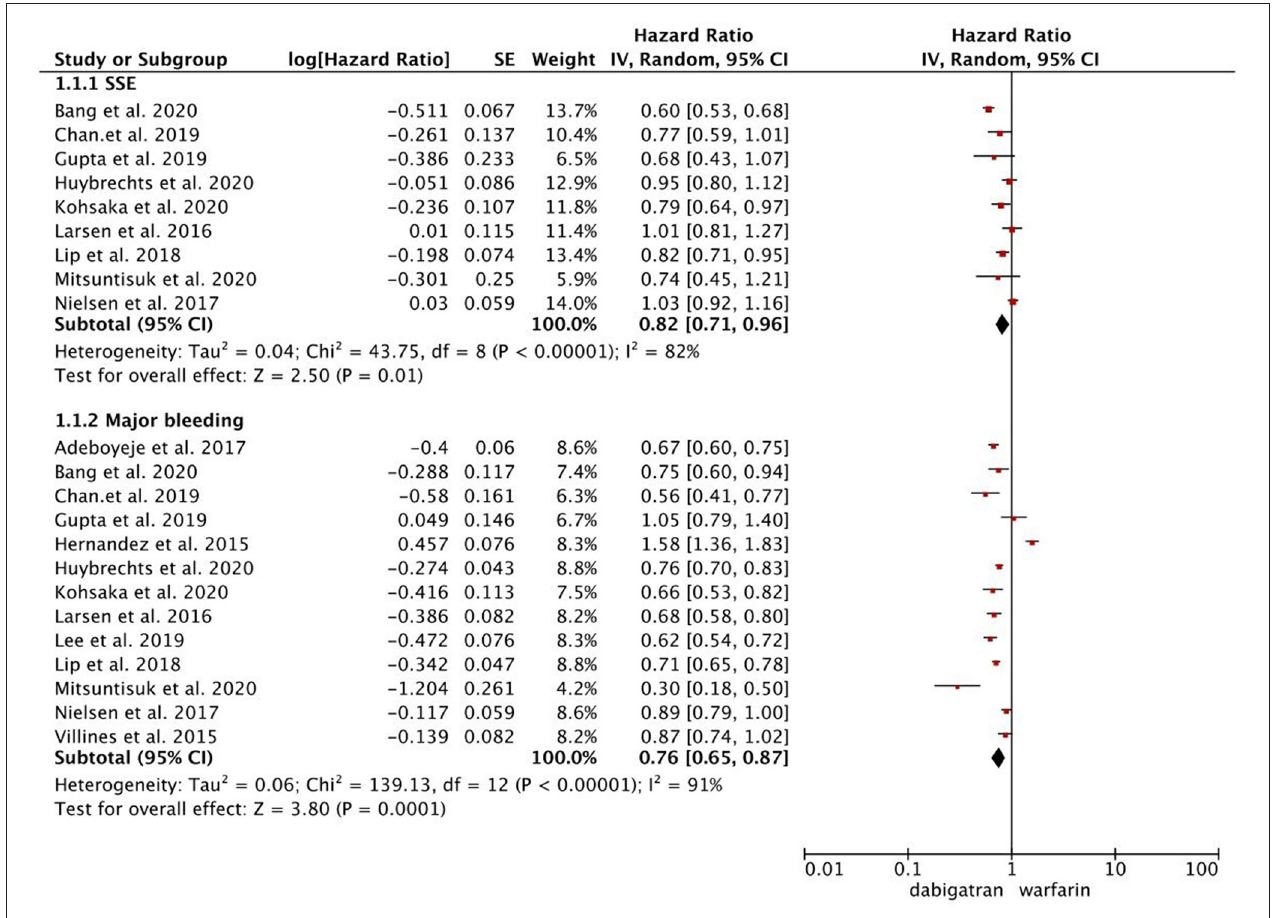
FIGURE 1 | Comparing the primary outcomes including SSE and MB of dabigatran vs. warfarin. SSE, stroke or systemic embolism; MB, major bleeding; HR, hazard ratio; CI, confidence interval; SE, standard error; IV, inverse of the